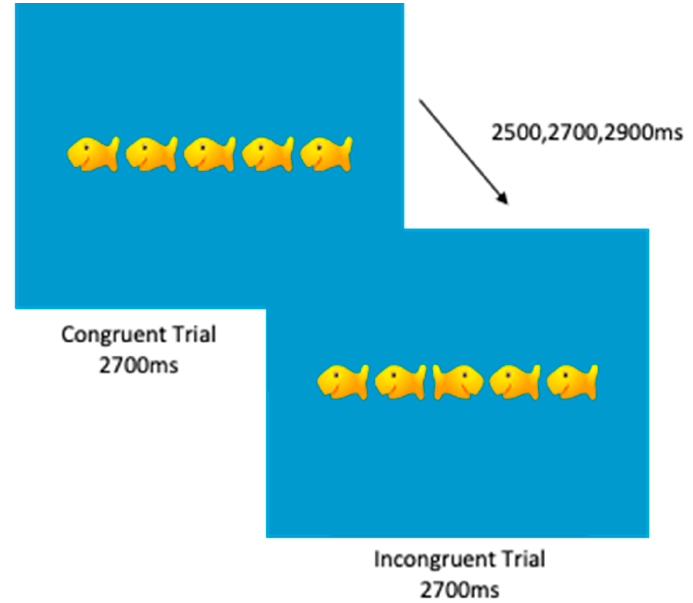
Figure 2. Depiction of a modified Eriksen flanker task for preschool-age children.